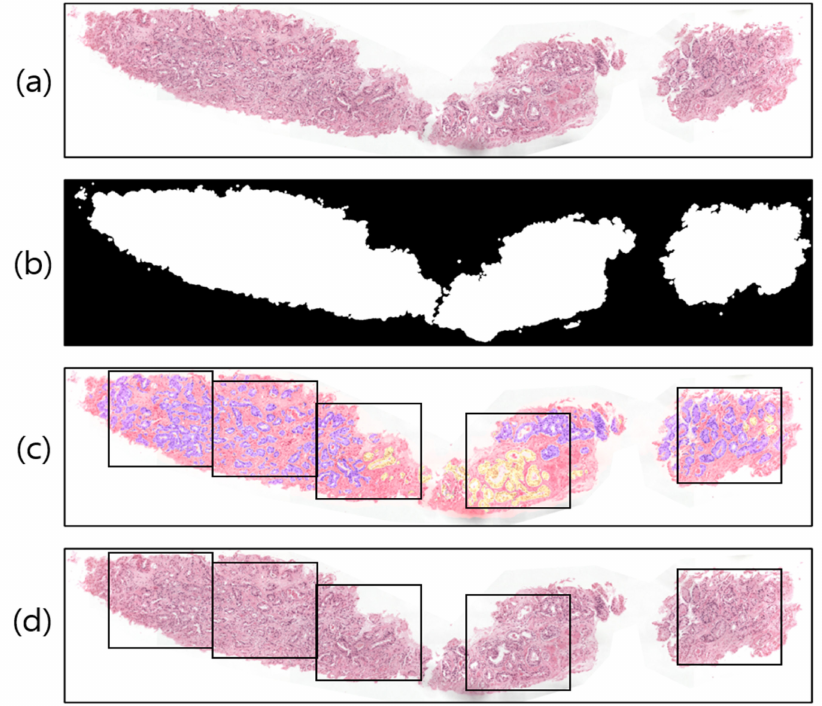
Figure 3. Examples of image preprocessing. ( a ) Original WSI. ( b ) Threshold result of ( a ). ( c ) Pathologist- annotated/ground-truth image with several nonoverlapping blocks for patching. The violet and yellow colors represent tissue regions with Gleason scores of 4 and 5, respectively. ( d ) The result of patching from the original